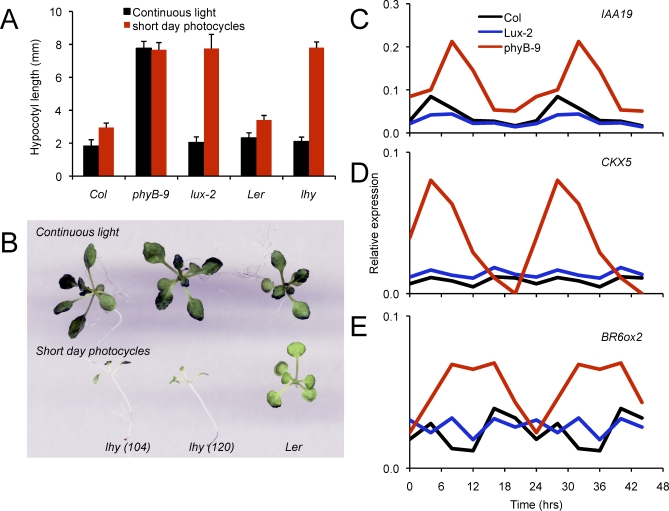
Light Signaling Directly Controls Phytohormone Gene Expression and Growth(A) Continuous light (black bars) rescues the long hypocotyl defect caused under short-day photocycles (red bars) in lux-2 and lhy mutants, but not in the phyB-9. Plants were grown under continuous light and thermocycles (12-h 22 °C/12-h 12 °C) to ensure synchronization of the circadian clock for expression studies; results without thermocycles (constant 22 °C) were the same as the results presented here and as those described previously [30,34]. Measurements are an average of at least ten 7-d-old seedlings, and error bars are ± standard deviation. Results represent three independent biological experiments.(B) Continuous light rescues the severe developmental defects of the lhy mutants under short-day photocycles. Two alleles of lhy, lhy (104) and lhy (120), and the parental Ler were grown as in (A) for 2 wk. The long hypocotyl phenotype of lhy under short-day photocycles is completely rescued under continuous light. Results represent three independent biological experiments.(C–E) Continuous light (and thermocycles) as in (A) restores the expression of (C) IAA19, (D) CKX5, and (E) BR6ox2 to wild type in lux-2, but not in phyB-9. The same pattern of expression as in lux-2 was observed for lhy (unpublished data). Expression was measured by qRT-PCR in two independent biological replicates.